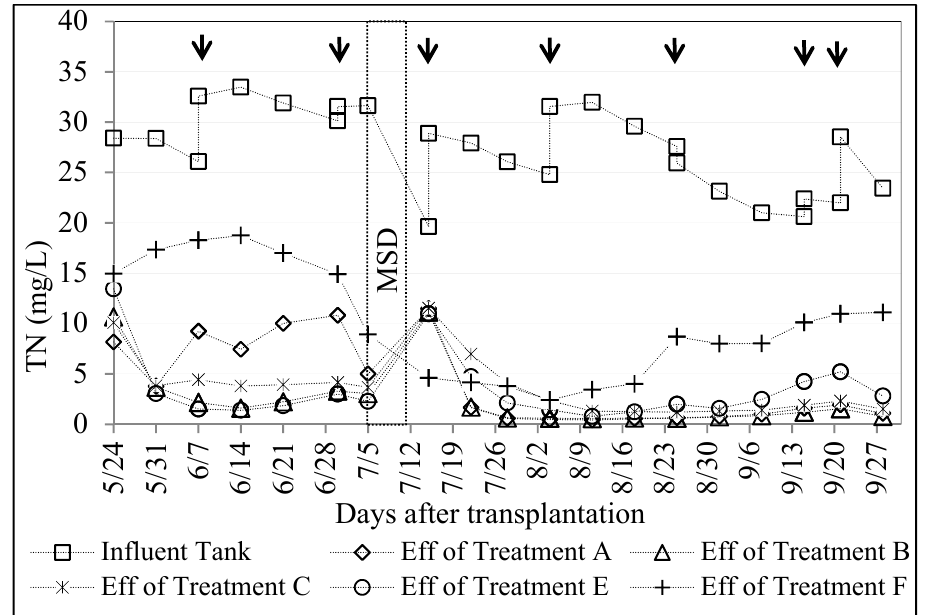
Figure 2. Total nitrogen (TN) of the irrigation water. Solid arrows indicate dates when treated wastewater was added to the influent tank, and MSD means midsummer drainage to dry up the soil layers.